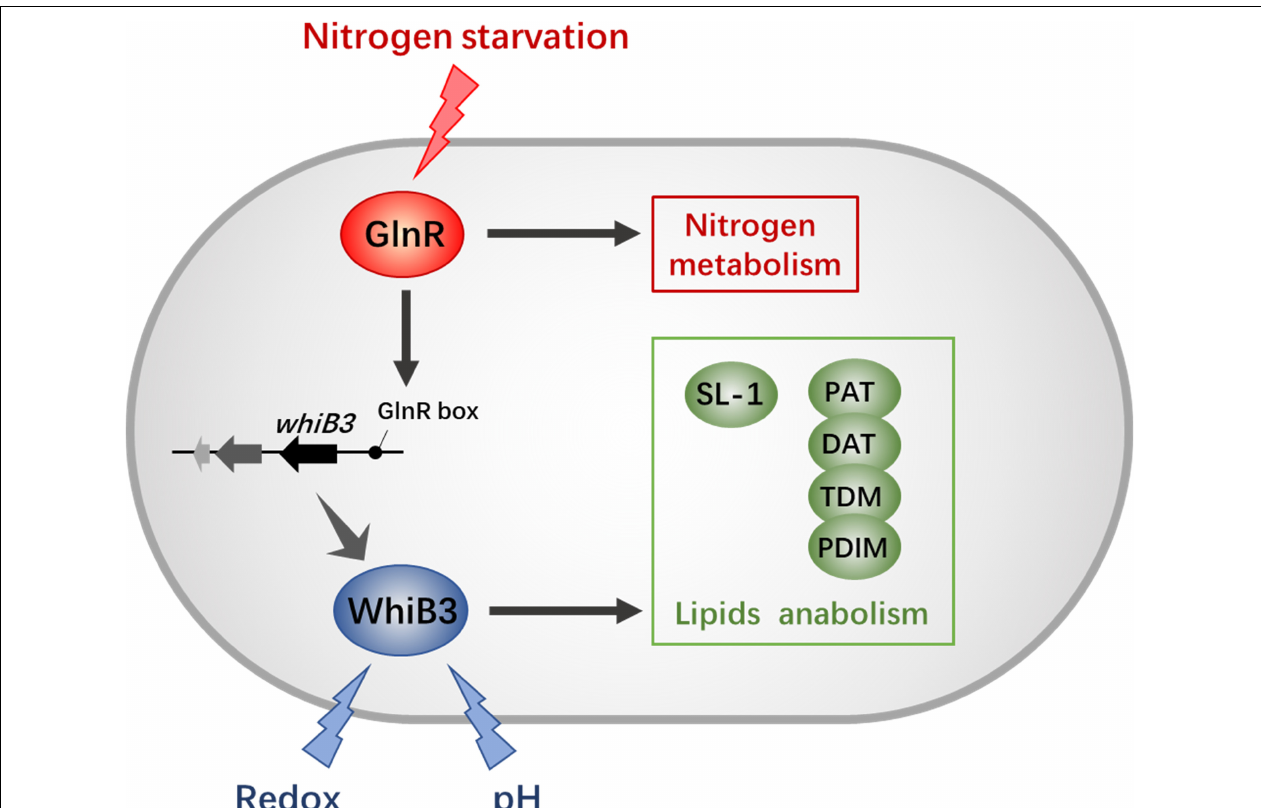
FIGURE 6 | The GlnR-mediated network of redox sensing and lipid anabolism. The black solid lines with arrows indicate positive transcriptional regulation; arrows indicate the positive control. The GlnR box indicates a GlnR-binding motif.